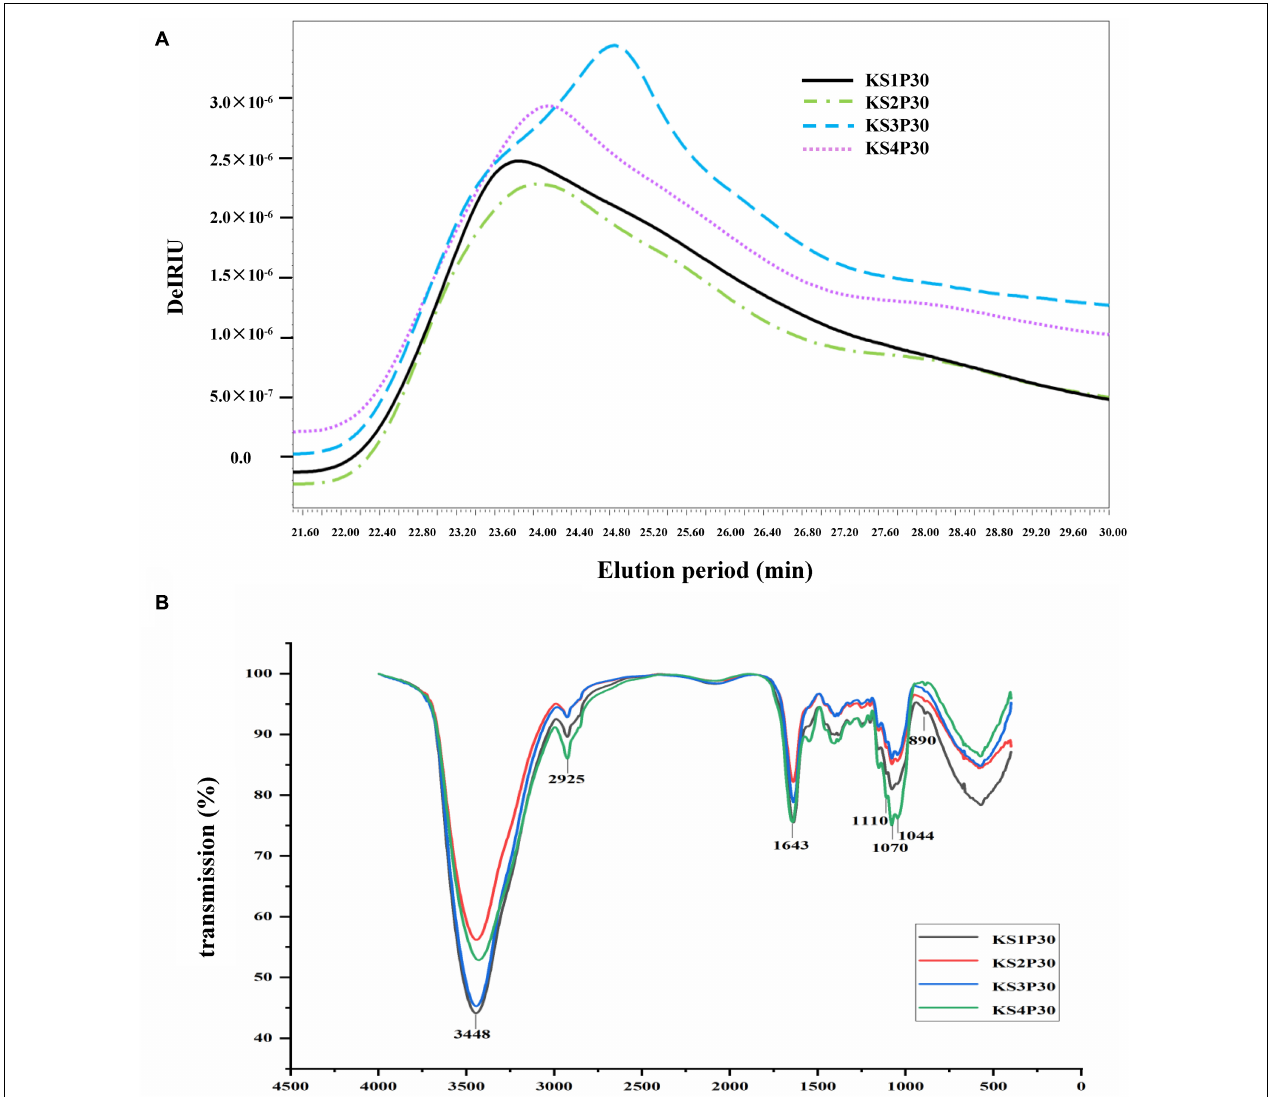
FIGURE 4 | Characteristics of polysaccharides obtained from different development stages. (A) Molecular weight distribution of polysaccharides. KS1P30, KS2P30, KS3P30, and KS4P30 represented 30% alcohol-precipitation polysaccharides obtained from the button stage, harvest stage, mature stage, and opening